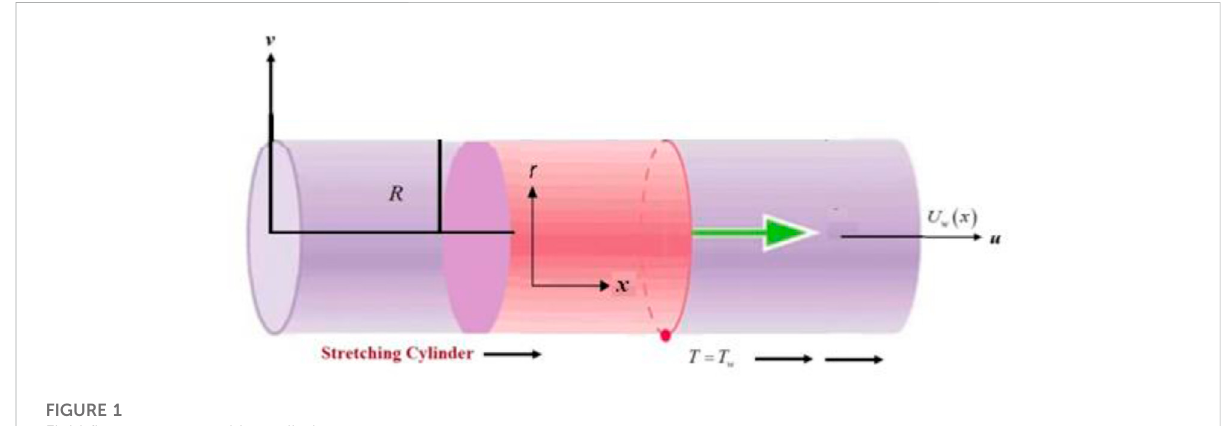
FIGURE 1 Fluid fl ow over a stretching